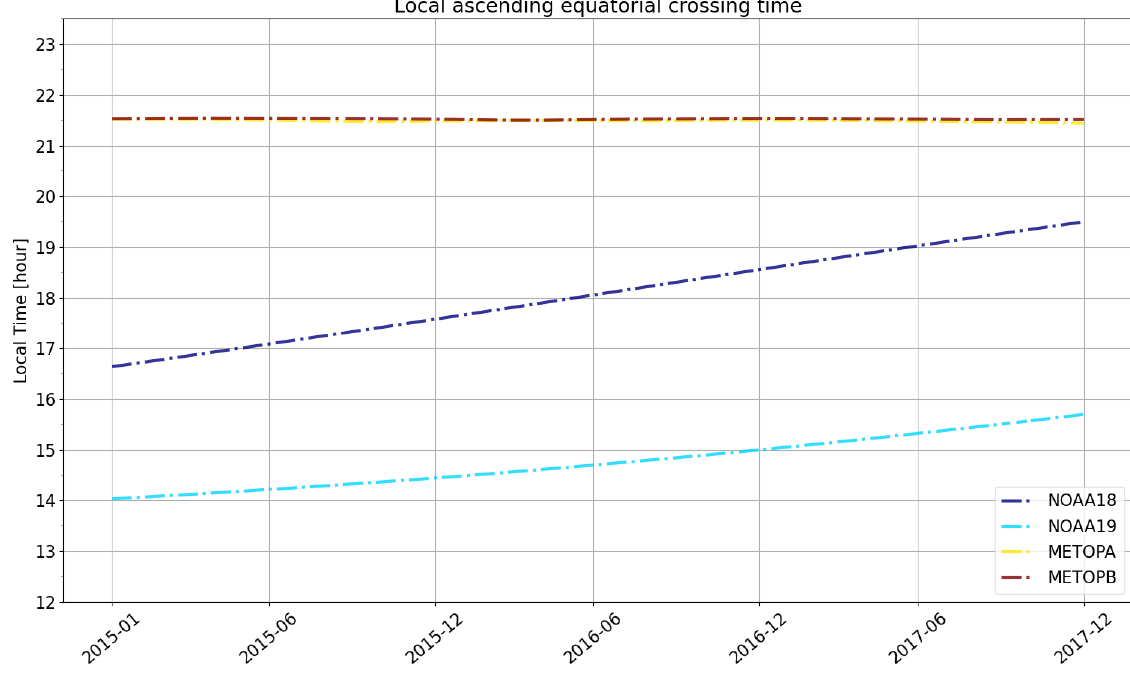
Figure 2. Local ascending equatorial crossing times of the four platforms considered in the global analysis over the period 2015–2017. An overall drift of about 2 h over the entire time window characterizes the NOAA-18/19